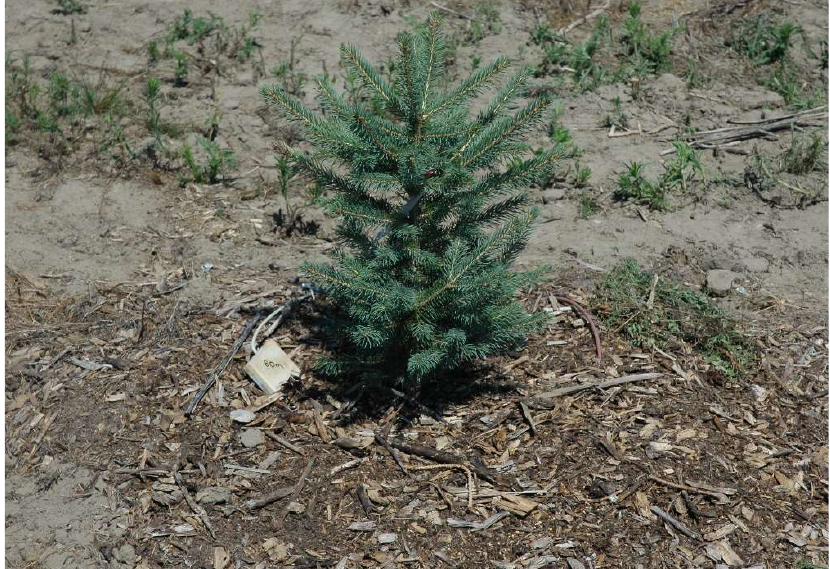
Figure 3. Hardwood chips used as organic mulch can prevent weed emergence and growth during the establishment phase of the Christmas trees. This hardwood mulch can also improve soil moisture content, maintain optimal soil temperature, and improve Christmas tree overall growth.